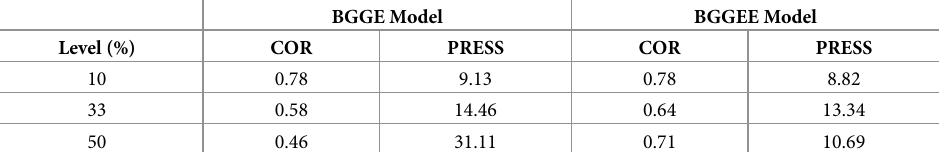
Table 2. Mean values of COR and PRESS for the BGGE and BGGEE models in three random, unbalanced